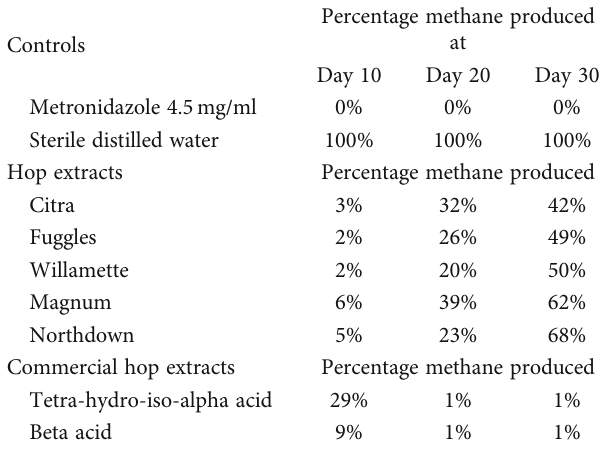
Table 1: The percentage reduction of methane by aqueous and commercial hop extracts, metronidazole (4.5 mg/ml), and water compared to an untreated control at 10-day time points over 30 days. Results are an average of 3 separate